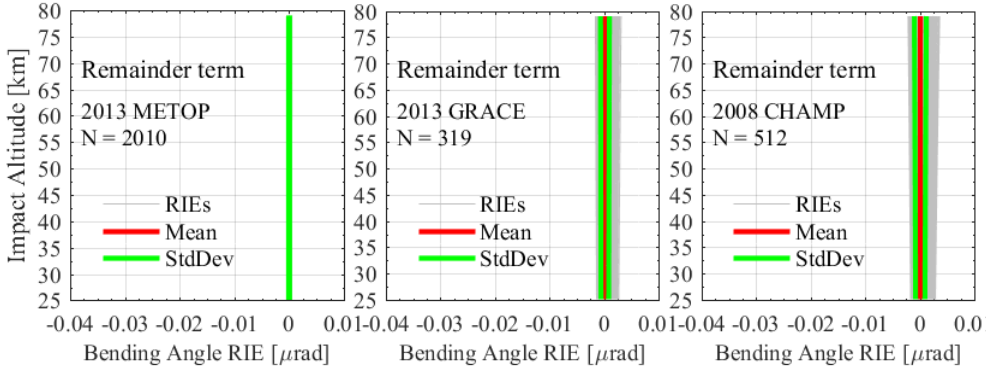
Figure 12. Profiles and their statistics of the BNe remainder term (rightmost term of Equation (11)) for the global ensemble data sets of MetOp-A / -B missions on 15 May and 15 July 2013 ( left panel ), GRACE mission on 15 May and 15 July 2013 ( middle panel ), and CHAMP mission on 14–16 July 2008 ( right panel ), respectively. In each subpanel, the individual bending angle RIEs (gray), their mean (heavy red), and their standard deviation (heavy green) are shown.